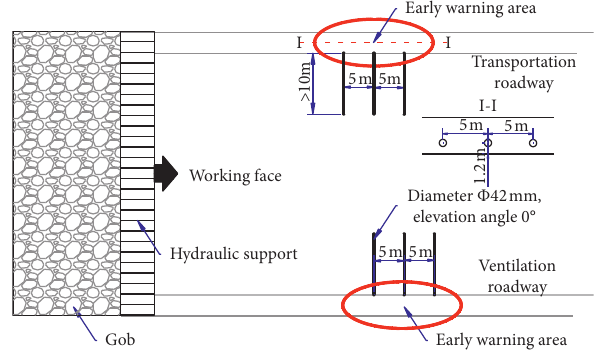
Figure 12: Blasting layout of the roadway side.